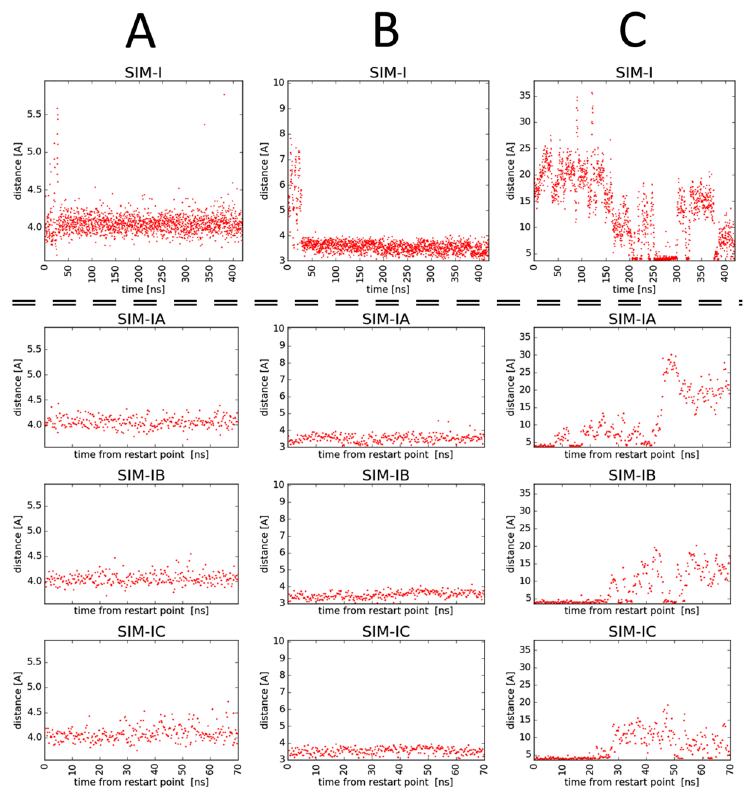
Figure 6. Time evolution of distances between ( A ) C γ atom of Asp320 and C ζ of Arg residue in compound 3 ; ( B ) O γ atom of Ser346 and C of Arg residue in compound 3 ; ( C ) C δ atom of Glu319